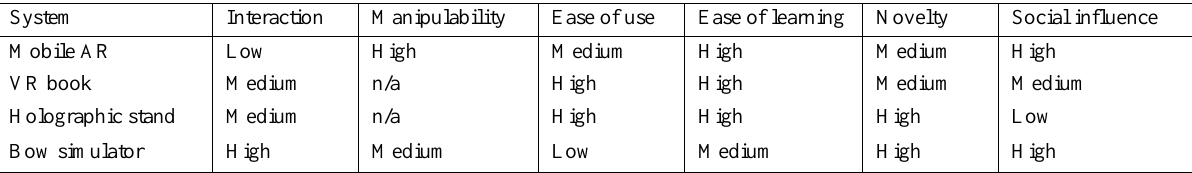
Table 1. Study parameters for each piece of